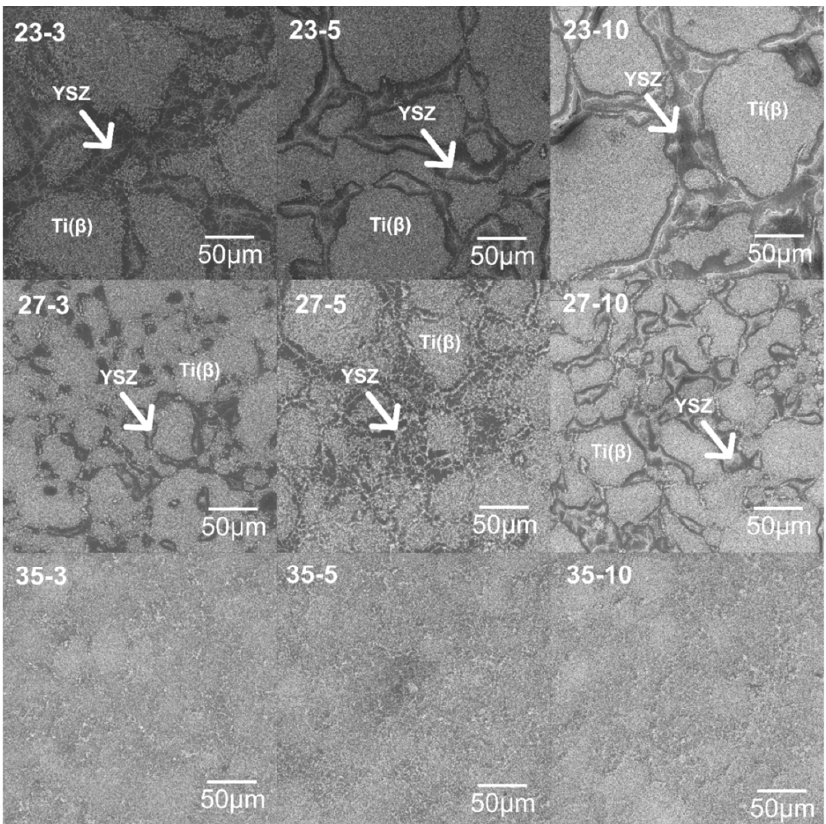
Figure 8. SEM microphotographs of sintered composites with visible darker initial powder grains boundary regions of YSZ aggregation.